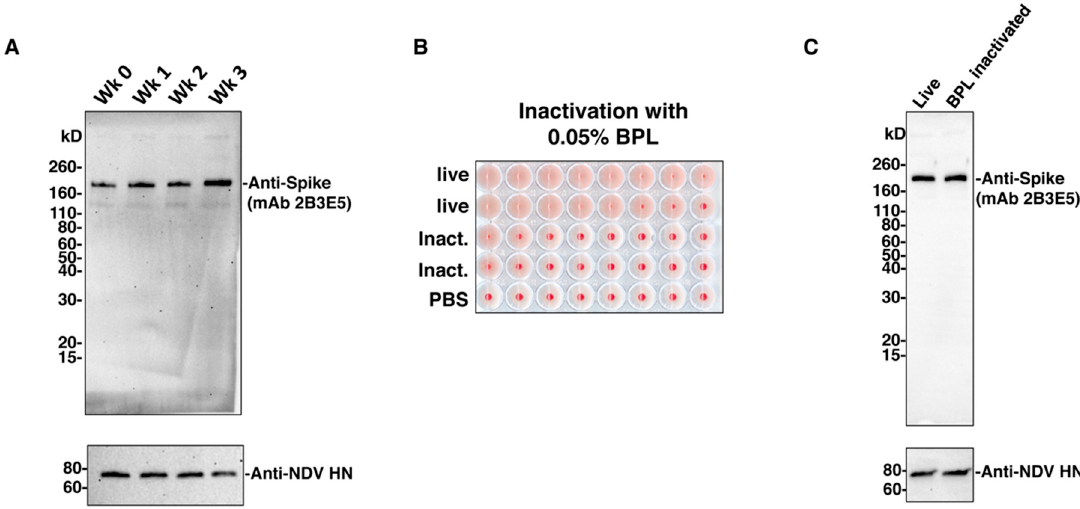
Figure 2. The S-F chimera is stable. ( A ) Stability of the S-F chimera at 4 ◦ C. Allantoic fluid containing the NDV-S virus was aliquoted into equal amounts (15 mL) and stored at 4 ◦ C. Virus from each aliquot was concentrated through a 20% sucrose cushion, re-suspended in an equal amount of phosphate bu ff ered saline (PBS), and then stored at − 80 ◦ C for several weeks (wk 0, wk 1, wk 2, and wk 3). One microgram of each concentrated virus was resolved onto 4–20% sodium dodecyl sulfate polyacrylamide gel electrophoresis (SDS-PAGE). Protein degradation was evaluated by Western blot using the S-specific mouse monoclonal antibody 2B3E5. The hemagglutinin-neuraminidase (HN) protein of NDV was used as an NDV protein control. ( B ) Inactivation of the virus by beta-propiolactone (BPL). Viruses in the allantoic fluid were inactivated by 0.05% BPL, as described previously. Clarified allantoic fluids with live and inactivated viruses were diluted in PBS (at 1000-fold dilution) and inoculated into 10-day-old embryonated chicken eggs. The eggs were incubated at 37 ◦ C for 3 days. The loss of infectivity of the inactivated virus was confirmed by the lack of growth of the virus determined by a hemagglutination (HA) assay. ( C ) Stability of the S-F before and after BPL inactivation. Live or inactivated (using 0.05% BPL) NDV-S virus was concentrated through a 20% sucrose cushion, as described previously. Two micrograms of live or BPL-inactivated virus were loaded onto 4–20% SDS-PAGE. Stability loss of the S-F was evaluated by Western blot, as described in A.